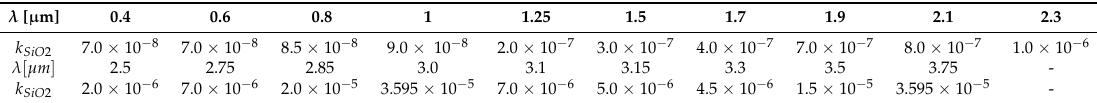
Table A1. Imaginary part for the refractive index of SiO 2 , after [63]. λ [ µ